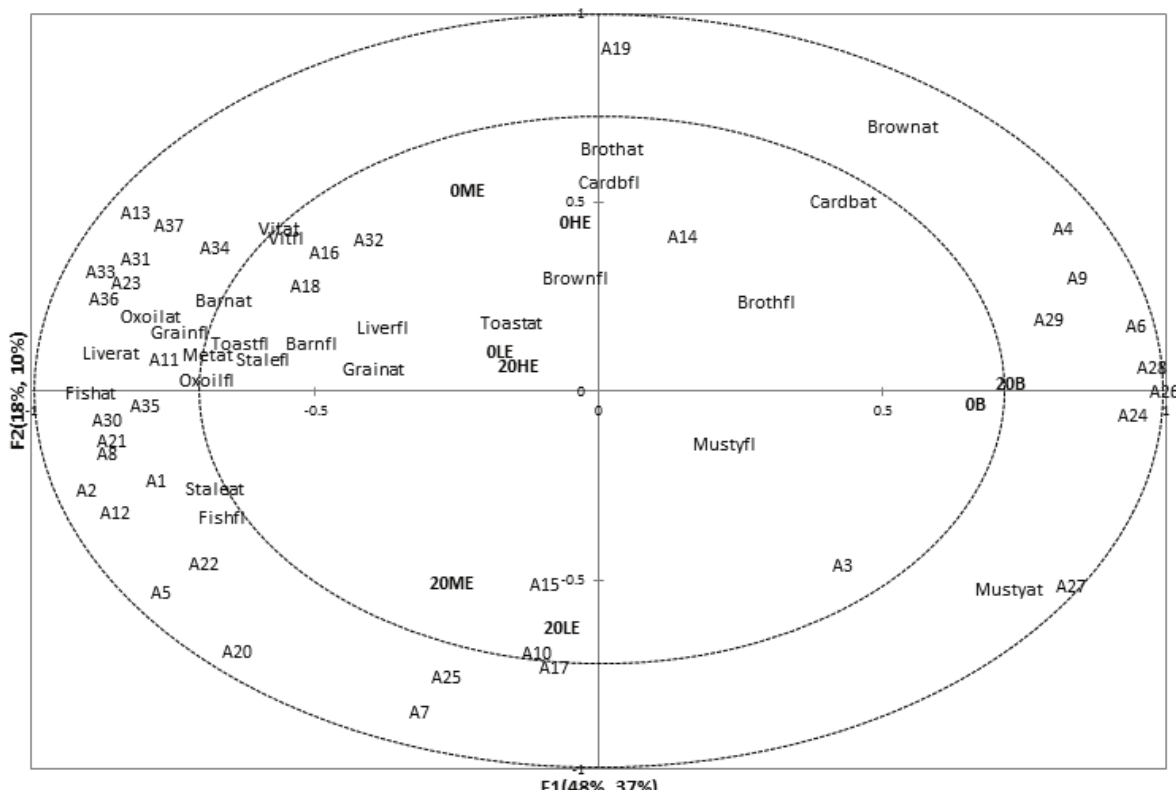
Figure 2. Partial Least Squares Regression Factors 1 and 2. Suffixes: ap – appearance; ar – aroma; fl – flavor; at –